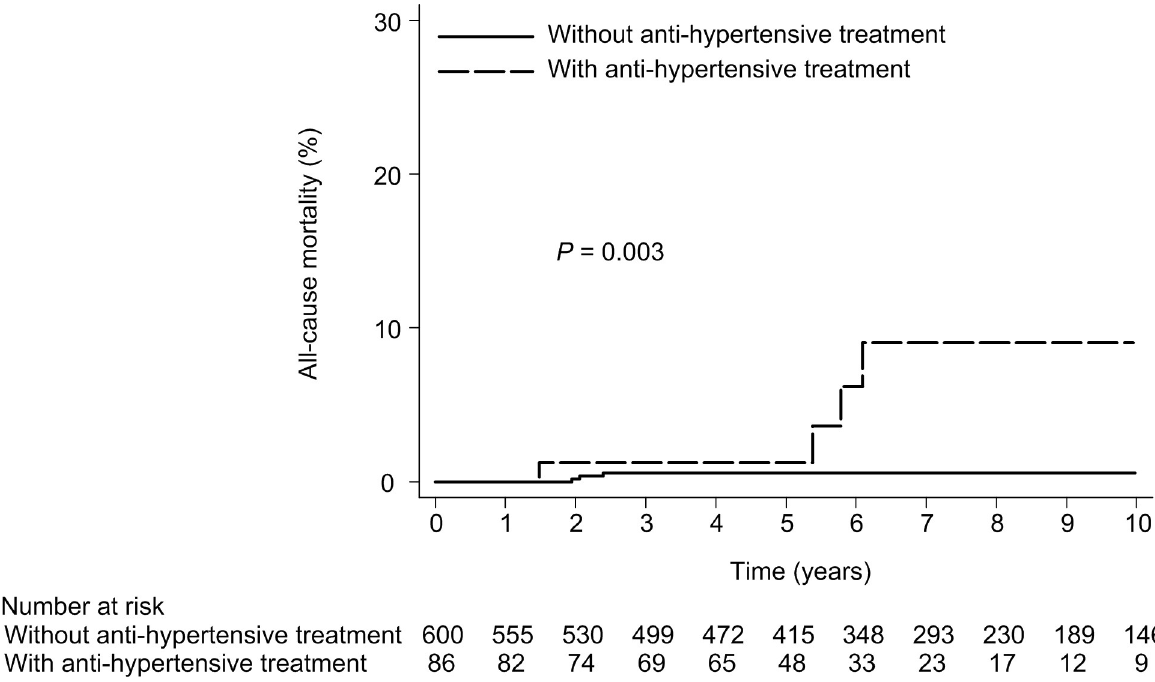
Fig 9. All-cause mortality according to anti-hypertensive treatment in mild fibrotic patients with SVR (10-year mortality rate, with vs. without anti-hypertensive treatment: 9.05% vs. 0.57%, HR = 7.72, 95% CI = 2.03–29.42, P = 0.003).